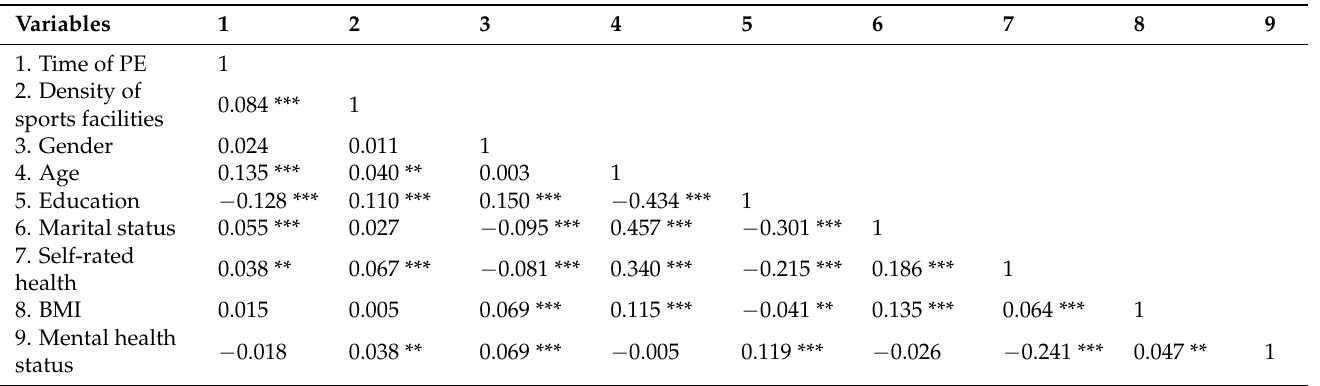
Table 2. Pearson correlation matrix of the study.